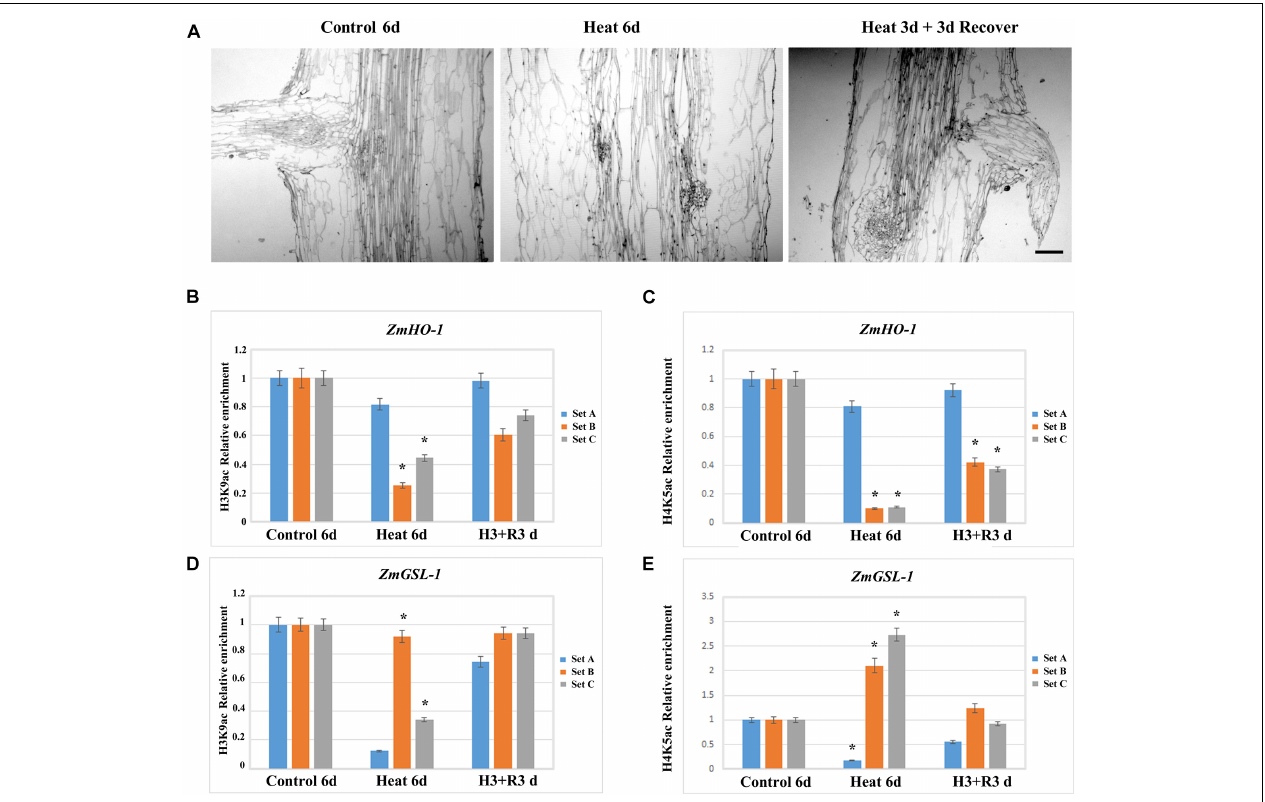
FIGURE 7 | Maize seedlings under heat treatment for 3 days were transferred to the control temperature condition for recovery, and the lateral root growth initiation was restored, while the level of epigenetic modification of ZmHO-1 and ZmGSL-1 gene promoter was restored to normal level. (A) Root section of maize seedlings at 6 days under control temperature condition and 6 days under heat treatment. (B) The alterations in H3K9ac in the upstream region of ZmHO-1 gene promoter under heat treatment group and restored group. (C) The alterations of H4K5a c in the upstream region of ZmHO-1 gene promoter in heat treatment group and restored group. (D) Changes in H3K9ac in the upstream region of ZmGSL-1 gene promoter under heat treatment group and restored group. (E) Alterations in H4K5ac upstream of ZmGSL-1 gene promoter under heat treatment group and restored group. All experiments were repeated three times. Asterisk ( ∗ ) indicated